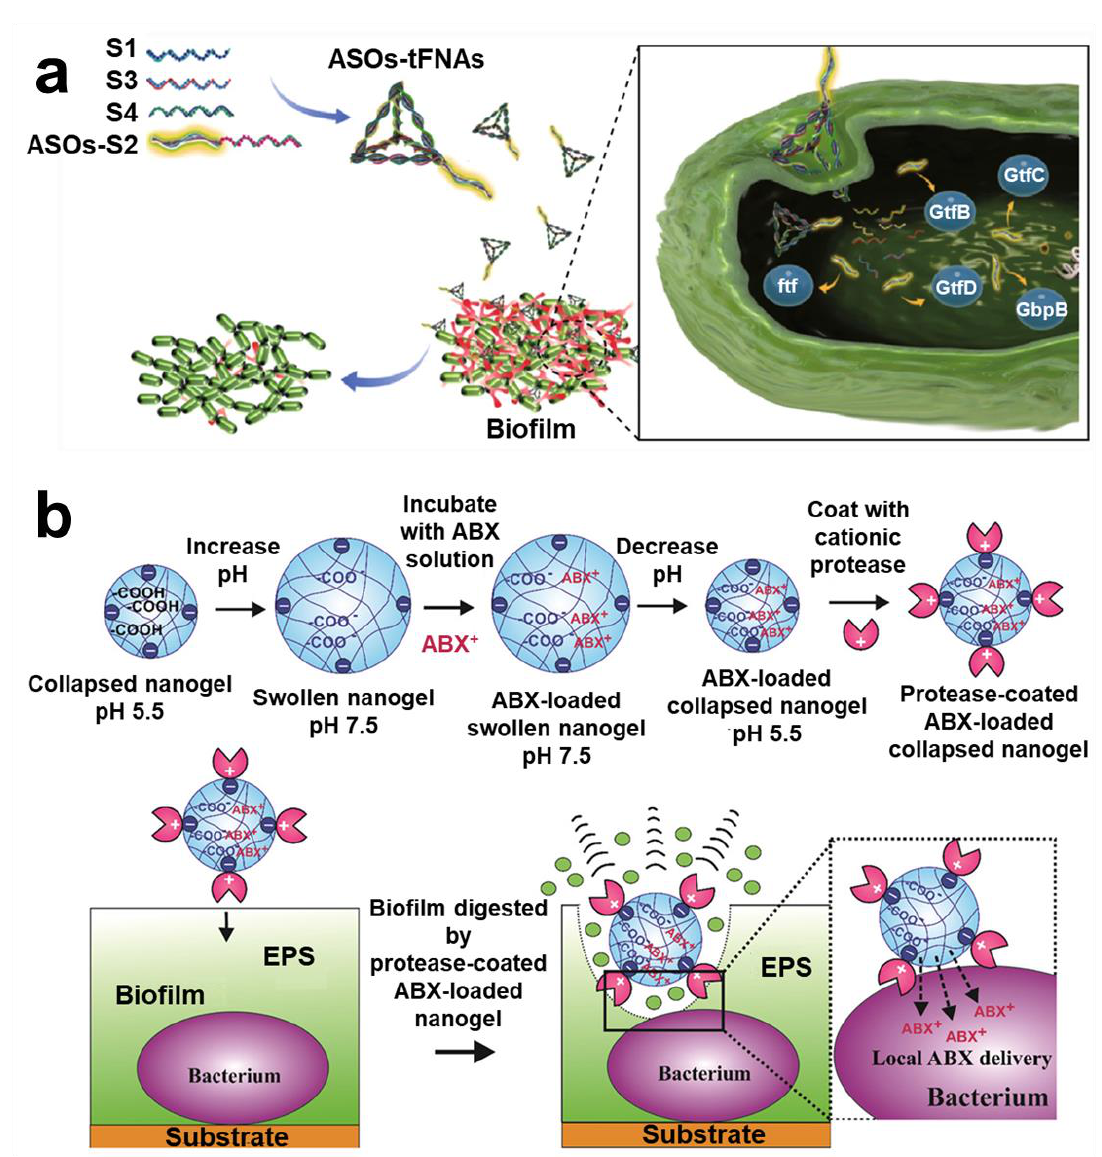
Figure 8. Protein targeting technology. ( a ) Scheme of a framework nuclear acid delivery that could target S. mutans and destroy biofilm bifunction. Reprinted from Ref. [163]. ( b ) Preparation process and targeting mechanism of gel carrier nanotechnology of protease functionalized. Reprinted with permission from Ref. [165]. Copyright 2019, Vesselin N.